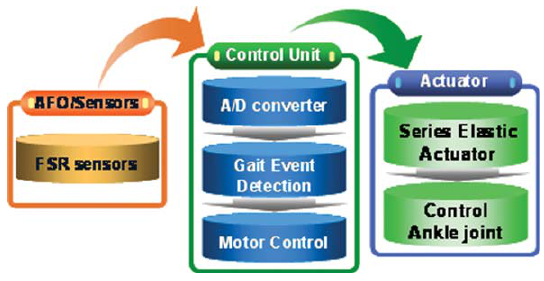
Fig. 1. Block diagram of the AAFO.